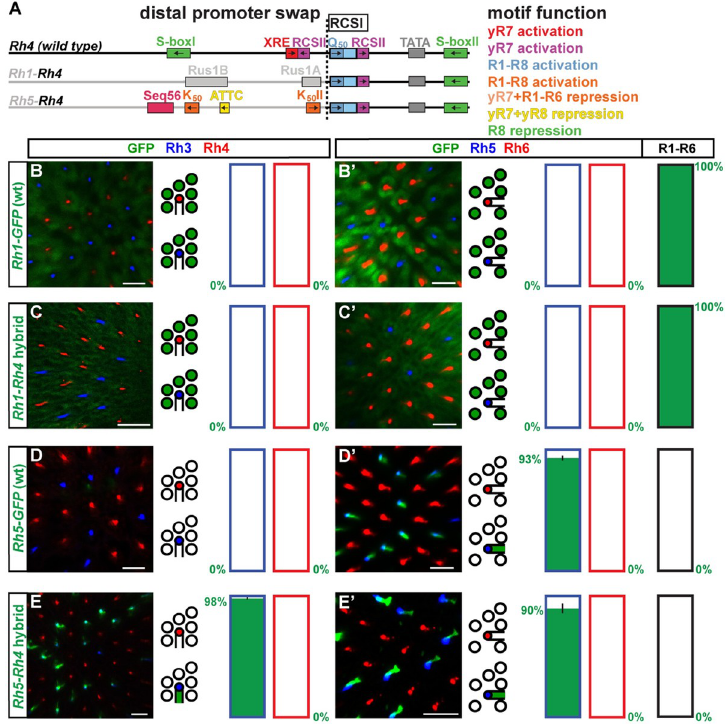
Fig 5. Hybrid promoters reveal compatible and incompatible distal and proximal motif combinations. (A) Schematic comparison of wild type Rh4 promoter and hybrids of the proximal core Rh4 promoter combined with the distal promoters of Rh1 or Rh5 . Note that Rh4 shares no distal motifs with Rh1 or Rh5 . The dotted vertical line indicates the break/fusion point of the hybrids. (B)—(E) Wild type vs . hybrid promoters driving GFP reporter expression (green) in the R7 layer. Rh3 (blue) labels pR7s and Rh4 (red) labels yR7s. Bar graphs show GFP co- expression in the Rh3 or Rh4 subset, respectively. (B’)—(E’) Wild type vs . hybrid promoters driving GFP reporter expression (green) in the R8 layer. Rh5 (blue) labels pR8s and Rh6 (red) labels yR8s. Bar graphs show GFP co- expression in the Rh5, Rh6, or R1-R6 subset. Green numbers indicate the mean percentage of GFP co-expressing photoreceptors, error bar represents standard error of the mean. (B) and (B’) The wild type Rh1 promoter drives subtype-specific GFP expression in the R1-R6 subset. N = 9 retinas and n = 630 R7s for (B); N = 8 retinas, n = 560 R8s and 3,360 R1-R6 PRs for (B’). (C) and (C’) The Rh1 - Rh4 hybrid drives subtype-specific GFP reporter expression in R1-R6 photoreceptors. N = 13 retinas and n = 1,014 R7s for (C); N = 8 retinas, n = 512 R8s and 3,072 R1-R6 PRs for (C’). (D) and (D’) The wild type Rh5 promoter drives subtype-specific GFP expression in the yR8/Rh5 subset. N = 10 retinas and n = 767 R7s for (D); N = 11 retinas, n = 997 R8s and 5,982 R1-R6 PRs for (D’). (E) and (E’) The Rh5 - Rh4 hybrid drives GFP expression in the pR7 subtype and the pR8 subtype. N = 11 retinas and n = 1,894 R7s for (E); N = 9 retinas, n = 566 R8s and 3,396 R1-R6 PRs for (E’). Scale bars, 10 μ